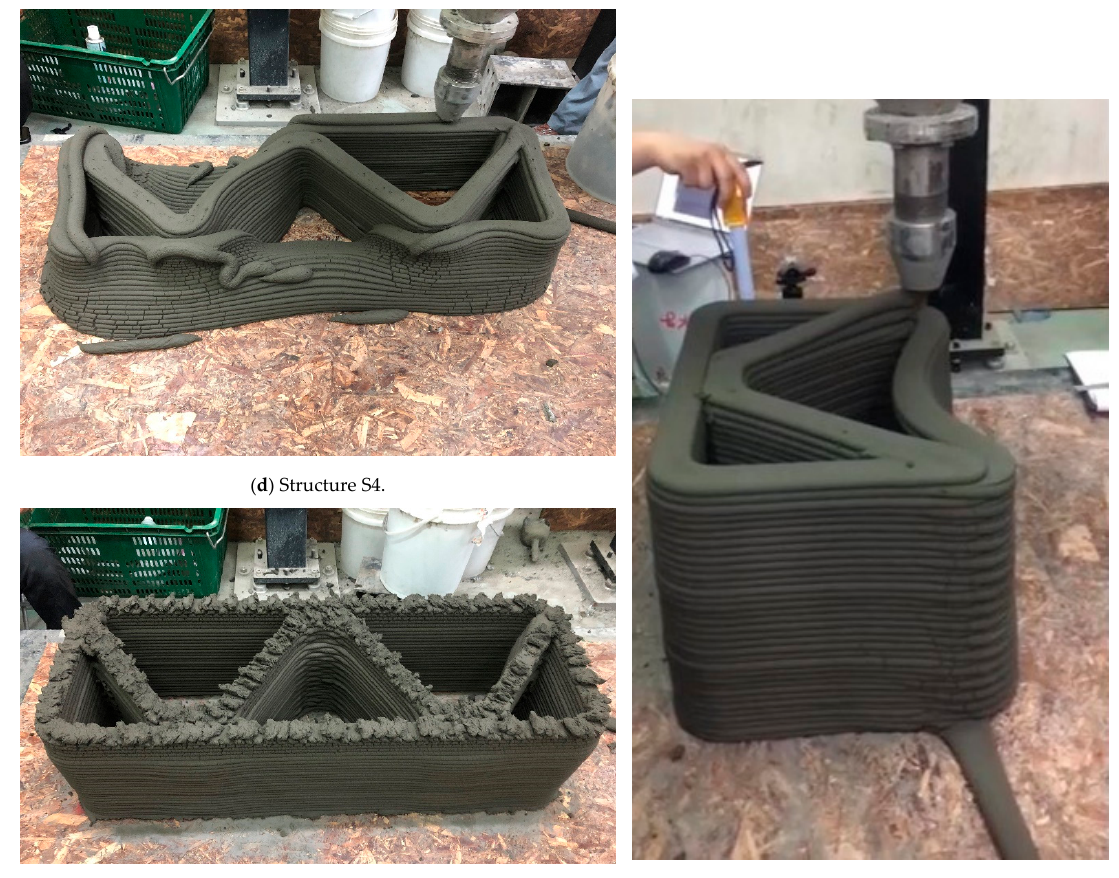
Figure 5. Ultimate state of structures S1 through S6.